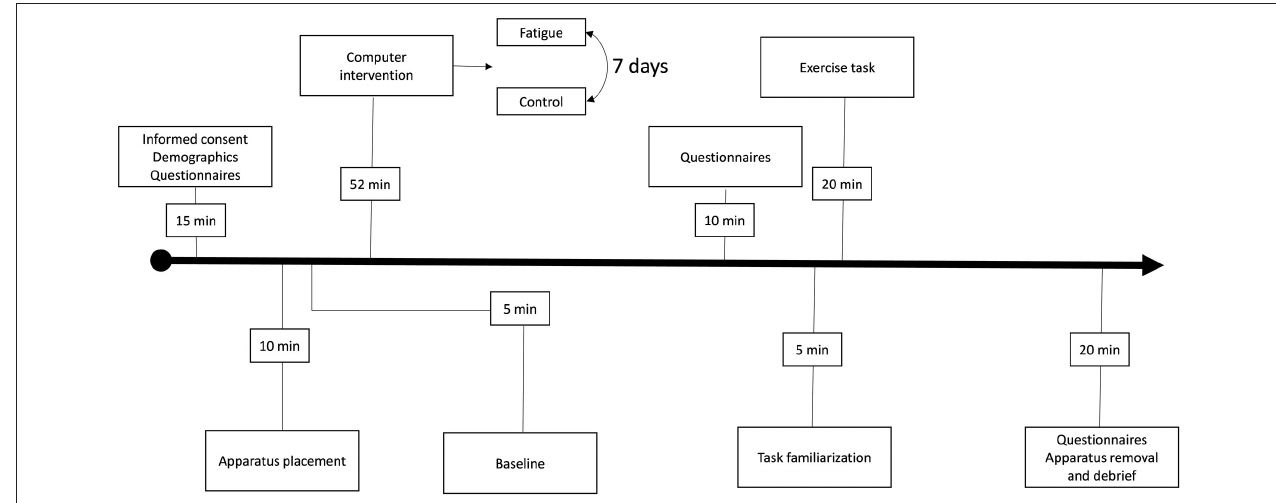
FIGURE 1 | Task timeline. Displayed is a timeline of events with corresponding durations.